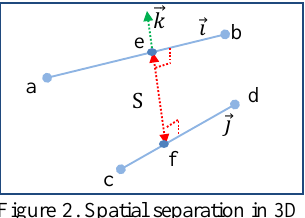
Figure 2. Spatial separation in